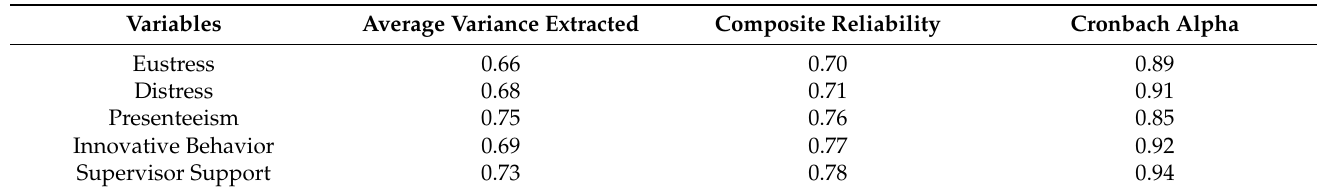
Table 4. Average variance extracted, composite reliability, and collective Cronbach